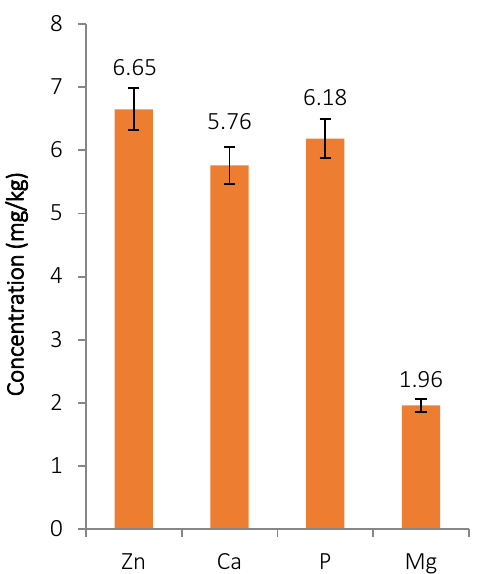
Figure 3. Mineral composition of A. occidentale leaf